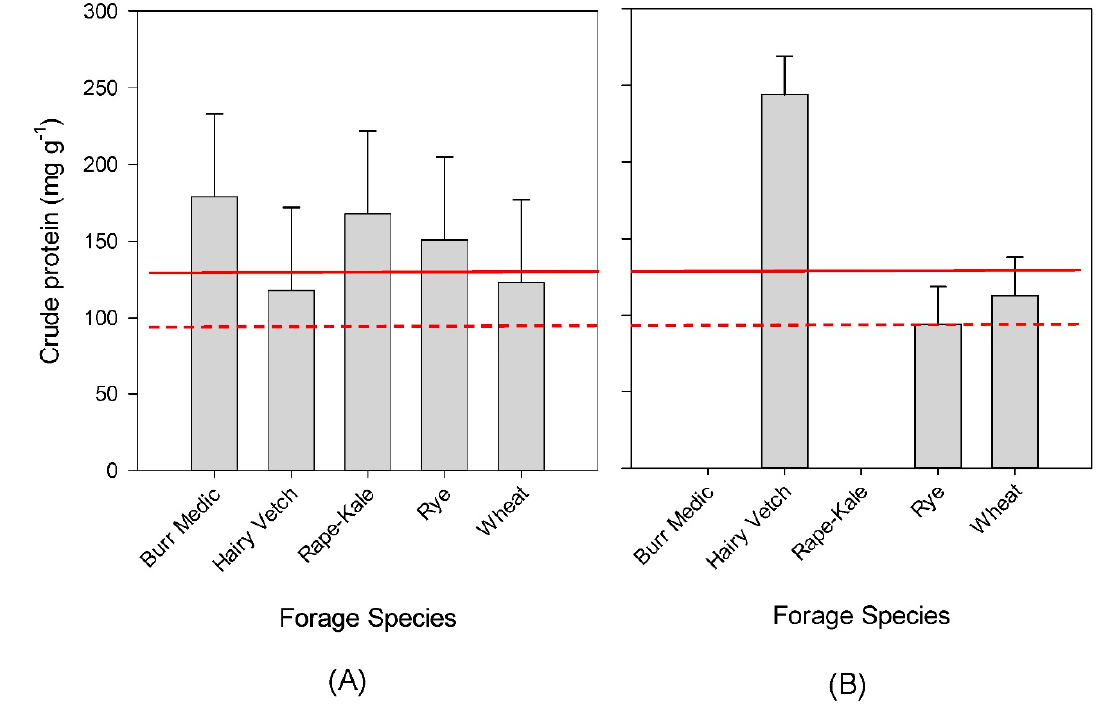
Figure 3. Comparison of crude protein concentration of cover crop forage species within each year. ( A ) Data were collected on 9 March, 23 March, and 22 April 2016 in Year 1 ( n = 14). ( B ) Data were collected on 6 March and 28 April 2017 in Year 2 ( n = 20). Data averaged over irrigation and tillage treatments (applicable in Year 2 only). Error bars represent standard error. The solid red line represents approximate protein requirements of growing steers, and the dashed red line represents the requirements of mature beef cattle.